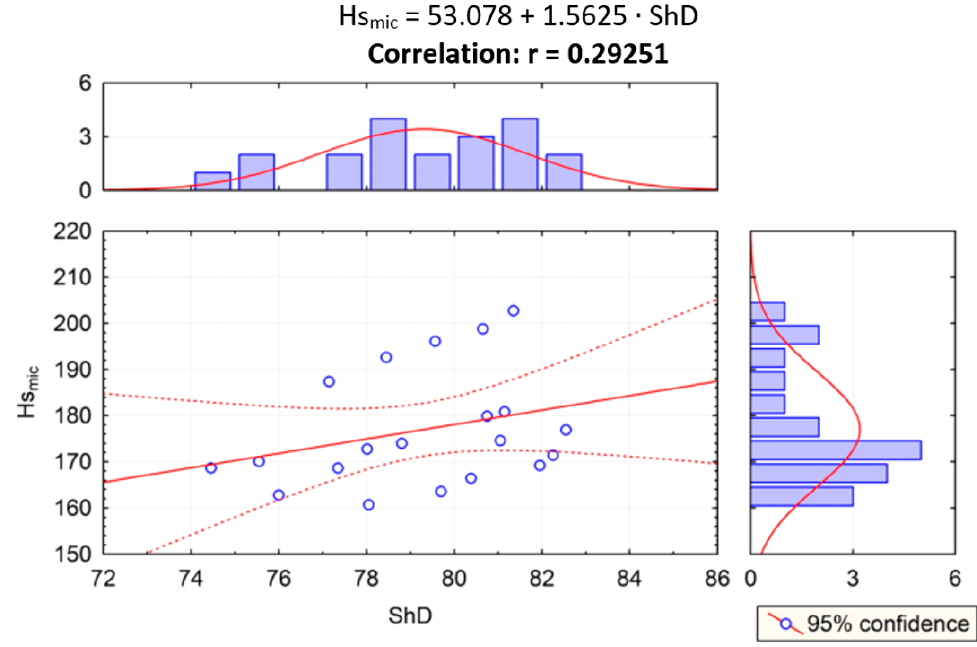
Figure 15. Dependence between scratch hardness Hs mic and Shore hardness ShD (r—correlation).